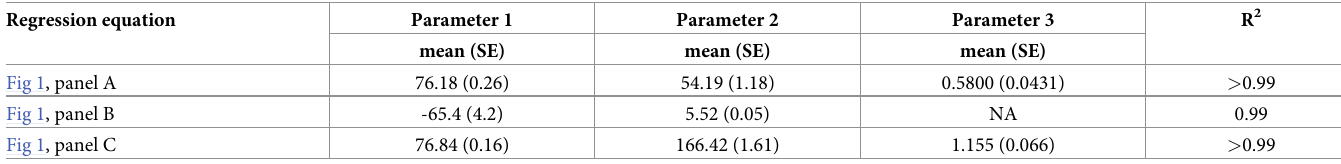
NA = not applicable; SE, standard error of the